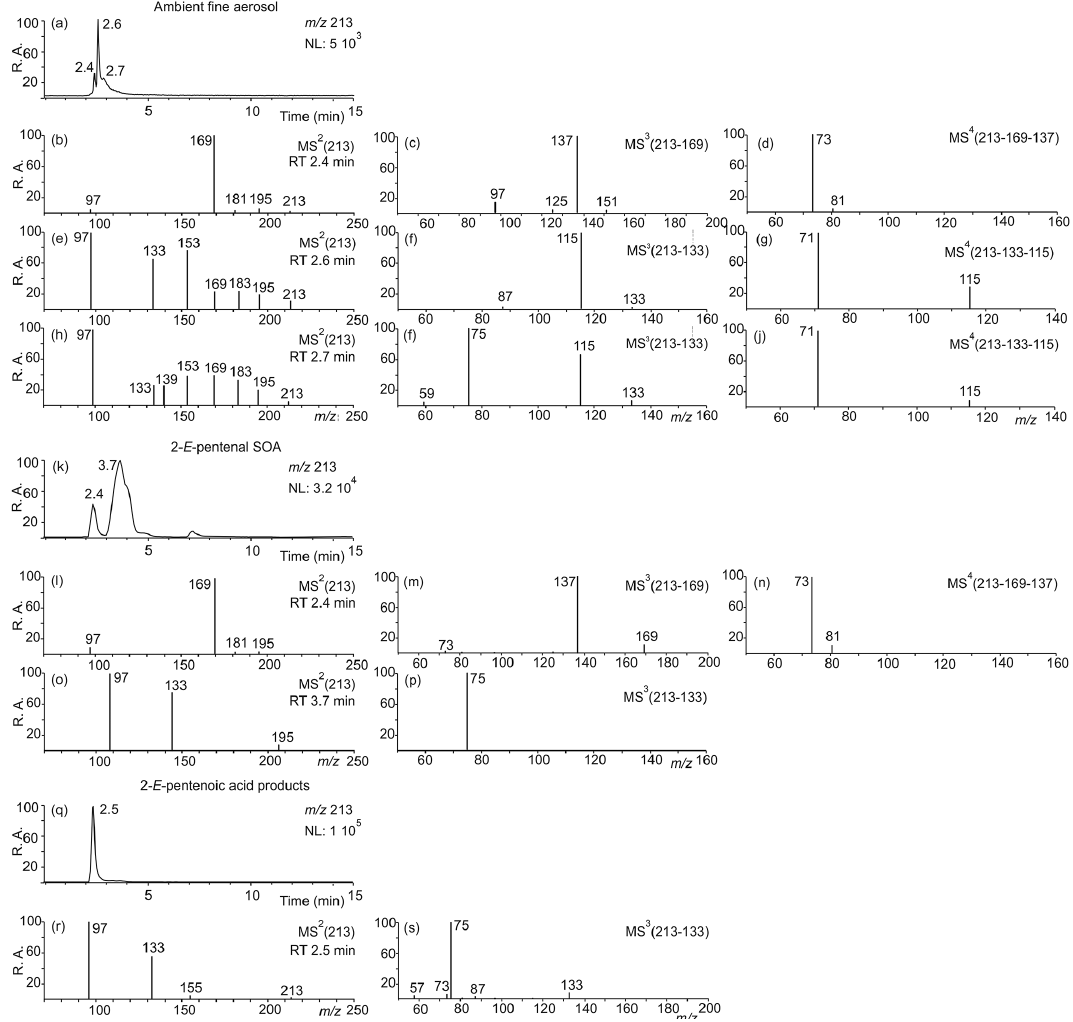
Figure 3. Selected LC–MS chromatographic data ( m/z 213 EICs) and selected MS data (MS 2 , MS 3 , and MS 4 product ion spectra) for ambi- ent fine aerosol (a – j) , 2- E -pentenal smog chamber SOA (k – p) , and 2- E -pentenoic acid aqueous-phase reaction products (q – s) . Abbreviation: NL, normalization